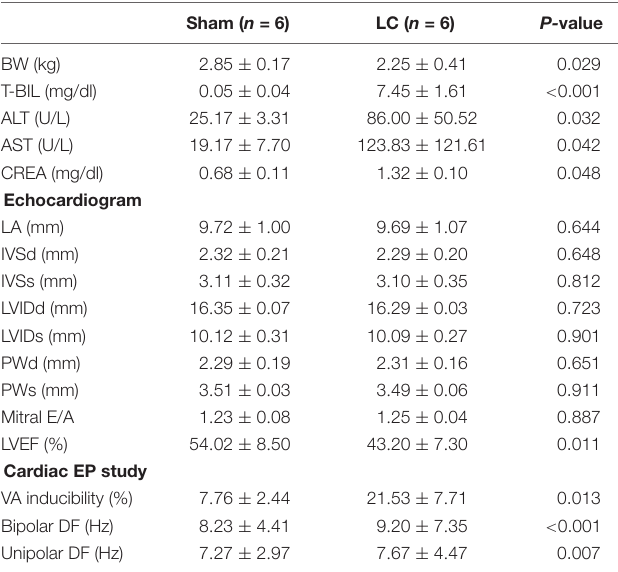
TABLE 1 | Comparison of body weight, blood analysis, echocardiogram, and cardiac electrophysiological parameters between two